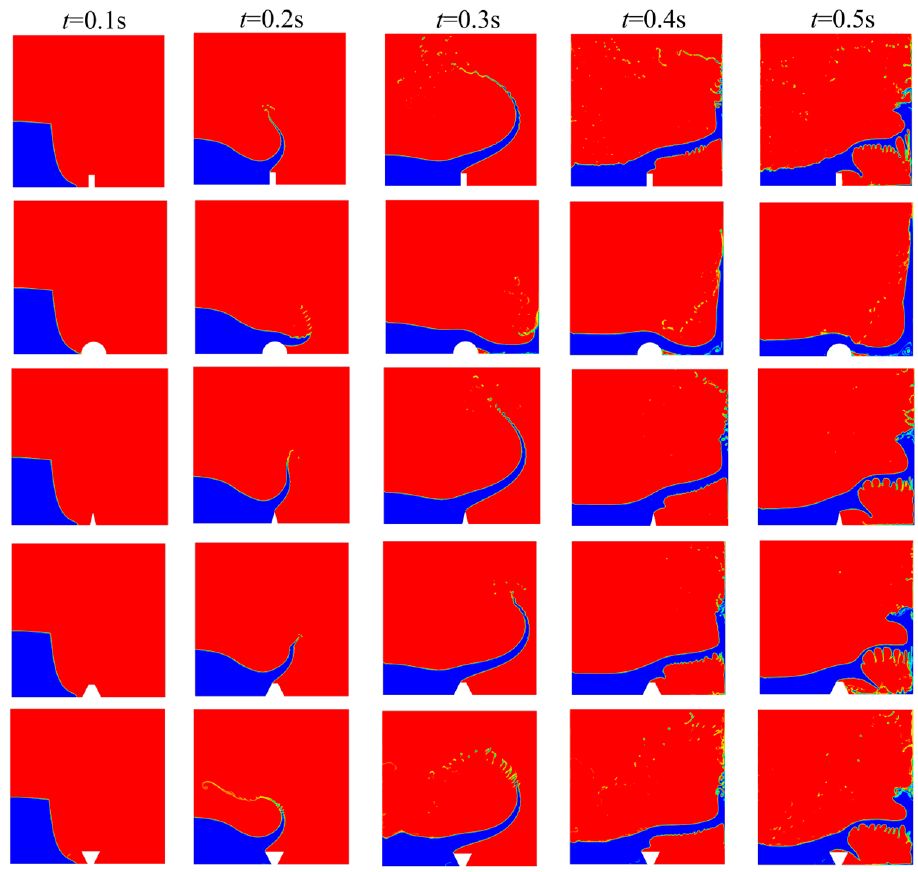
Figure 6. The free surface flow field of obstacles of different shapes at 0.1–0.5 s (from top to bottom, it is rectangular, semi-circular, triangular, regular trapezoid and inverted trapezoid). Figure 7 shows the free surface flow field of obstacles of different shapes at 0.6–1.0 s, at t = 0.3 s, the water tongues of four obstacles continued to move towards the top right, making an elongated crescent-shaped water whip. Simultaneously, water droplets continue to emerge from the front of the water flow. At t = 0.4 s, the water whip collides with the container’s right wall. At the instant of impact, there is insufficient time for air to disperse, resulting in the formation of bubbles of varying sizes in the water. Under the influence of gravity, the water begins to flow down the right container wall. The air bubbles disperse and spread out as the water flows below. Simultaneously, dispersed water droplets separate from the base of the water whip. A strip of water breaks from the water whip above the obstruction and spills out at the same instant the water whip hits the right wall of the container. At time t = 0.5 s, the water body descends and collides from the right wall to the bottom of the container, causing water droplets to splash. The bulk of the water body on the water whip is driven onto the right wall of container by rear water body. The